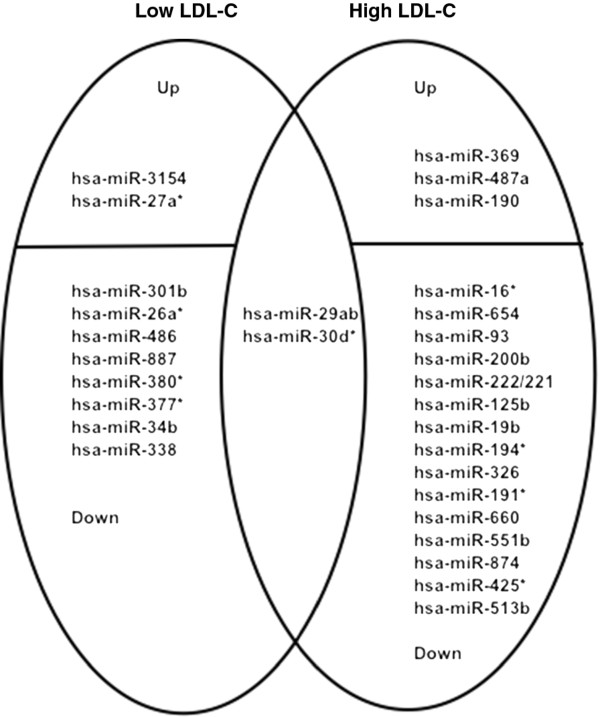
Families of baboon liver differentially expressed miRNAs. The Venn diagram includes both up- and down-regulated miRNAs (p ≤ 0.05) in low and high LDL-C baboon responders in response to the HCHF diet challenge.